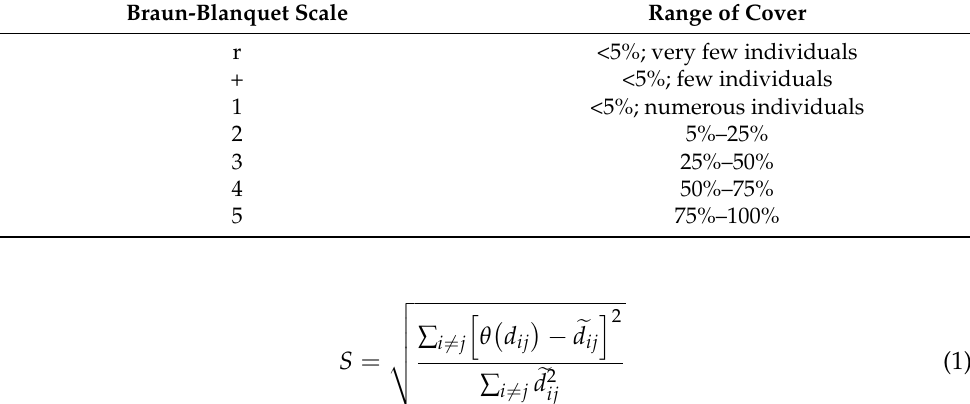
Table 2. Braun-Blanquet cover abundance